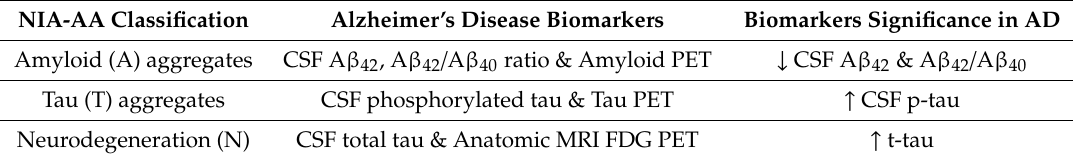
Table 1. Biomarkers based upon National Institute on Aging and Alzheimer’s Association (NIA-AA) classification